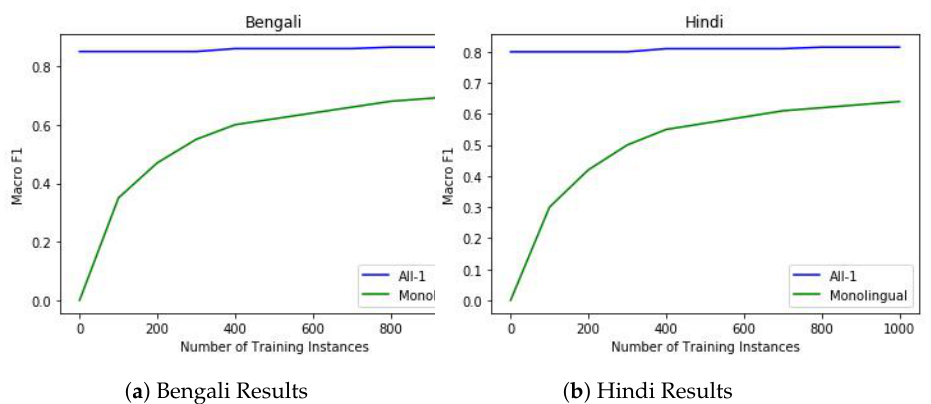
Figure 2. Transfer learning impact in offensive language identification for Bengali and Hindi. Mono- lingual indicates that the model was trained from scratch, while All-1 indicates that the model was trained on all the languages except that